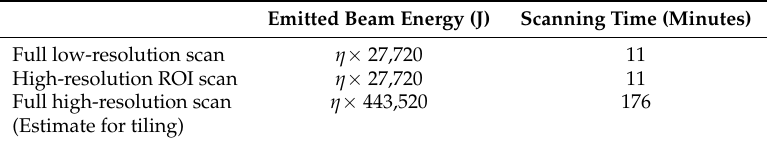
Table 4. The scanning times and emitted beam energy of the experiments. The third row contains an estimate of the duration of a full high-resolution scan with a detector tiling strategy, where a virtual large projection image is created by stitching the images for several detector positions. To achieve similar resolution as the high-resolution ROI scan, 16 detector positions would have to be stitched together. The emitted beam energy is used as a proxy for the radation dose absorbed by the object. The efficiency of the source η is multiplied by the power P = 42 W applied to the X-ray tube, and the scanning time in